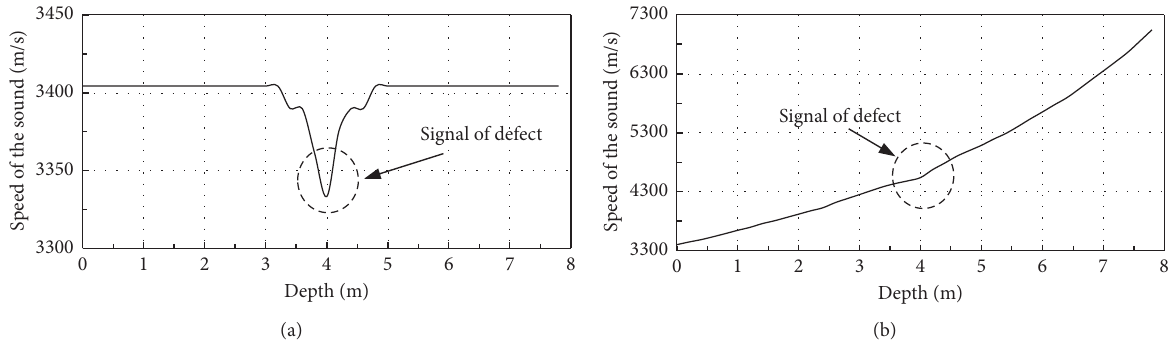
Figure 7: The results of defective piles with parallel acoustic tube and inclined acoustic tube. The results of the defective pile with (a) the parallel acoustic tube and (b) the inclined acoustic tube.